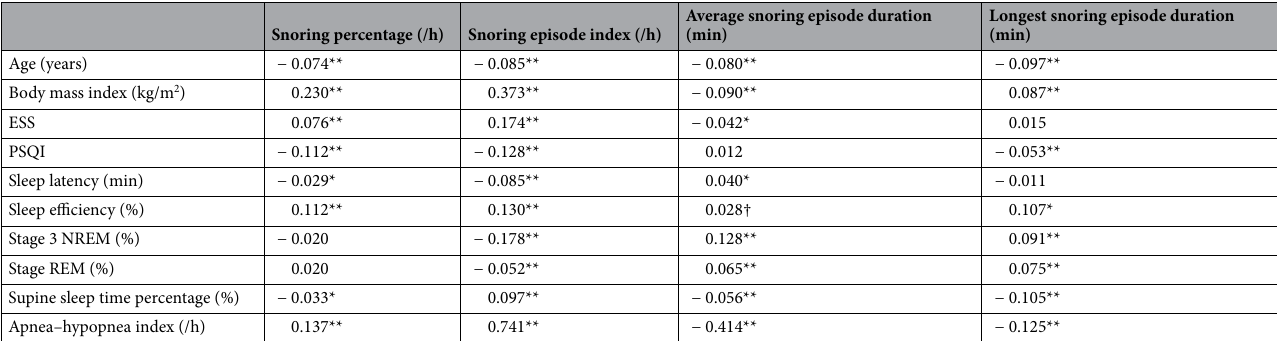
Table 3. Correlation between the snoring parameters and polysomnography parameters. ESS, Epworth Sleepiness Scale; PSQI, Pittsburgh Sleep Quality Index; NREM, non-rapid eye movement; REM, rapid eye movement. * P < 0.05, ** P <